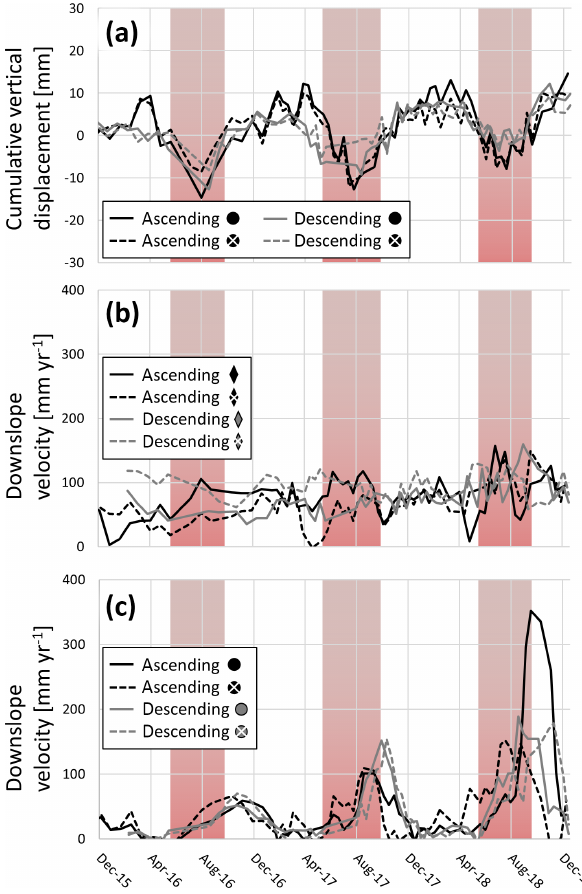
Figure 6. Surface displacement time series of both ascending (black, dashed black) and descending (grey, dashed grey) data of various areas throughout the Qugaqie basin highlighting the three seasonal patterns. June to September are shown with a red back- ground as they display the strongest monsoon activity and air tem- peratures > 0 ◦ C (Zhang et al., 2013). (a) Cumulative vertical dis- placement showing the seasonal heave–subsidence cycle of the HSM at two locations near the stream of the main valley (black dots in Fig. 5b). (b) Downslope velocity time series of the four gravity- driven landforms (rhombi in Fig. 7a) with relatively constant veloc- ities (blue areas in Fig. 7a). (c) Freeze–thaw-driven displacement patterns on four slopes (dots in Fig. 7a) with accelerated displace- ments in summer and comparatively minor displacements in winter (red areas in Fig. 7a). Panels (b) and (c) display moving average values of the closest four values in